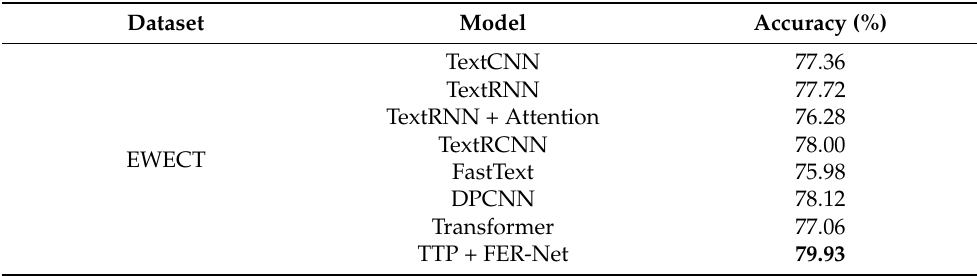
Table 4. Implicit sentiment analysis on EWECT dataset. (Two classifications: positive,